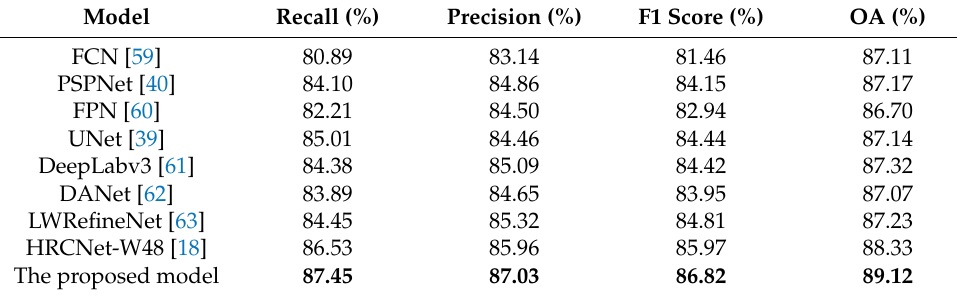
Table 6. Results for the Vaihingen dataset with the above models.